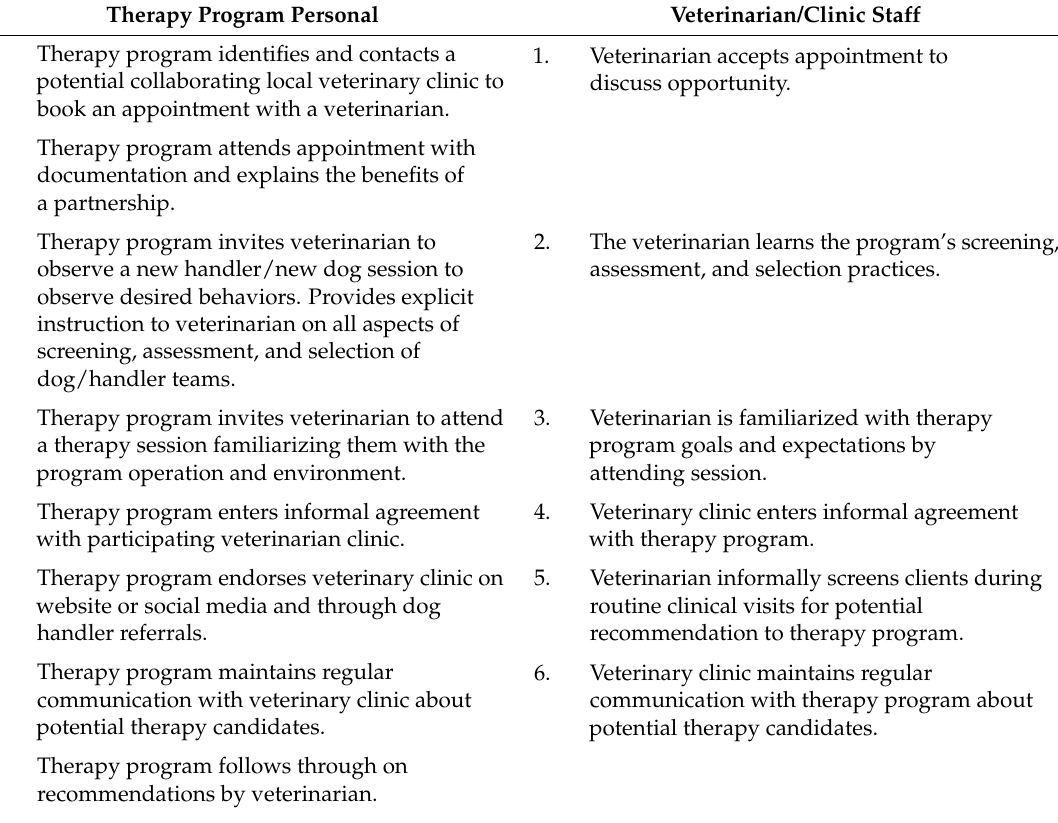
Table 2. Stepwise model to build clinic—canine therapy